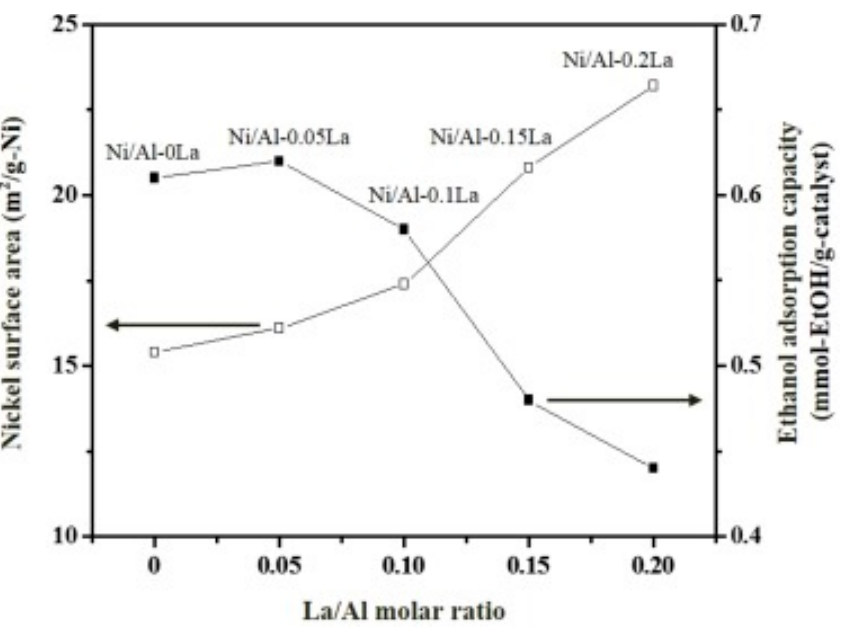
Figure 8. Nickel surface area and ethanol adsorption capacity as a function of the La/Al molar ratio in Ni/ x La 2 O 3 -Al 2 O 3 ( x = 0, 0.5, 0.1, 0.15 and 0.2) catalysts. Reprinted with permission from Ref. [92]. Copyright 2022 Elsevier.